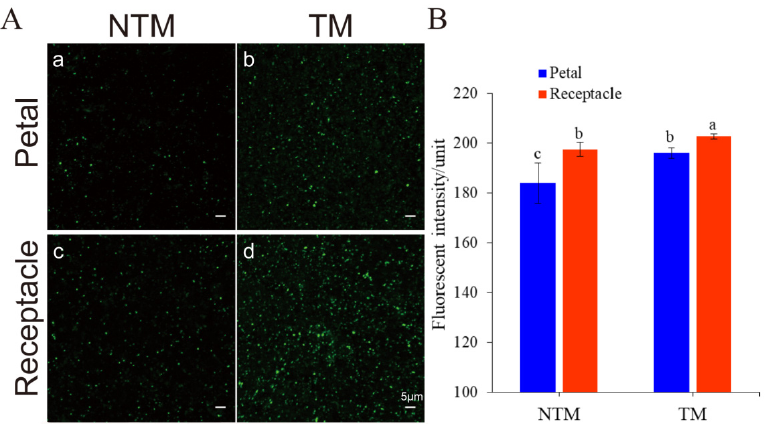
Figure 3. Mitochondrial dynamics in the receptacle and petals during the NTM and TM stages, as determined using MitoTracker Green (MTG). ( A ) Mitochondria labeled with MTG: Mitochondria in the petals during the NTM ( a ) and TM ( b ) stages. Mitochondria in the receptacle during the NTM ( c ) and TM ( d ) stages. ( B ) Comparison of mean fluorescence intensity in the receptacle and petals during the NTM and TM stages. The mean mitochondrial intensity in the petal during the TM (female) stage and NTM (bud) stage were 196.06 ± 2.04 and 184.00 ± 8.13, respectively. Additionally, the receptacle during the TM (female) stage and NTM (bud) stage were 202.69 ± 1.06 and 197.41 ± 2.83, respectively. The different lowercase letters indicate a significant difference in fluorescence intensity of mitochondria ( B ) between the floral stages according to the t -test. Data were analyzed from 10 flowers of TM and NTM stage, 3 sections (thermogenic vs. non-thermogenic) of each flower, 6 view fields for observation (88.56 µ m 2 per field). Data in the bars are the mean ± standard error and compared using the t test analysis. p < 0.01. Scale bars, 5 µ m.